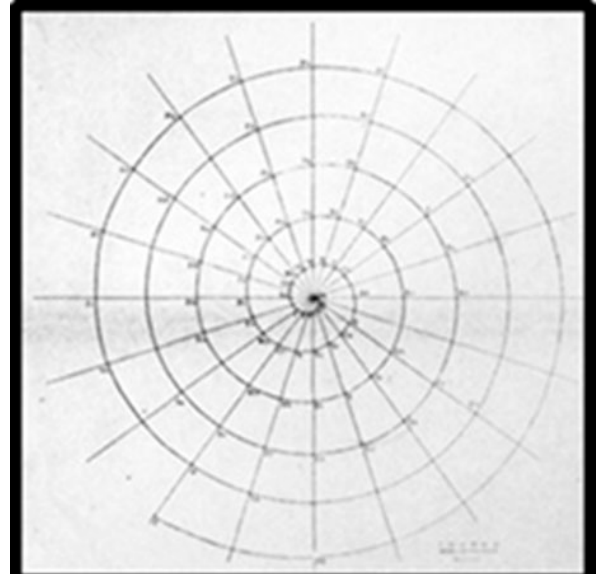
Figure 13. The 1902